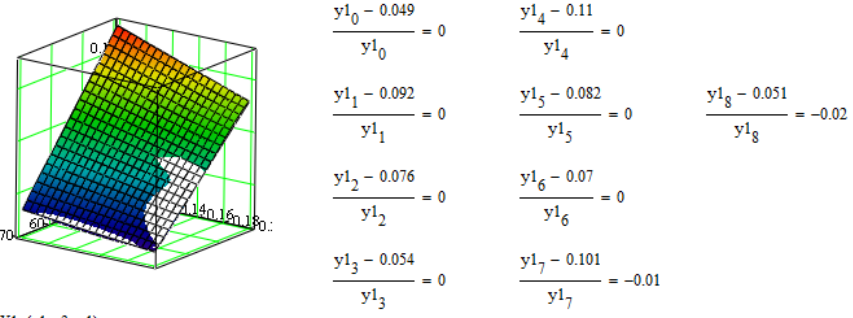
Fig. 3. Comparison of the graphical interpretation of the experimental and theoretical response surfaces and determina- tion of the relative calculation error using equation